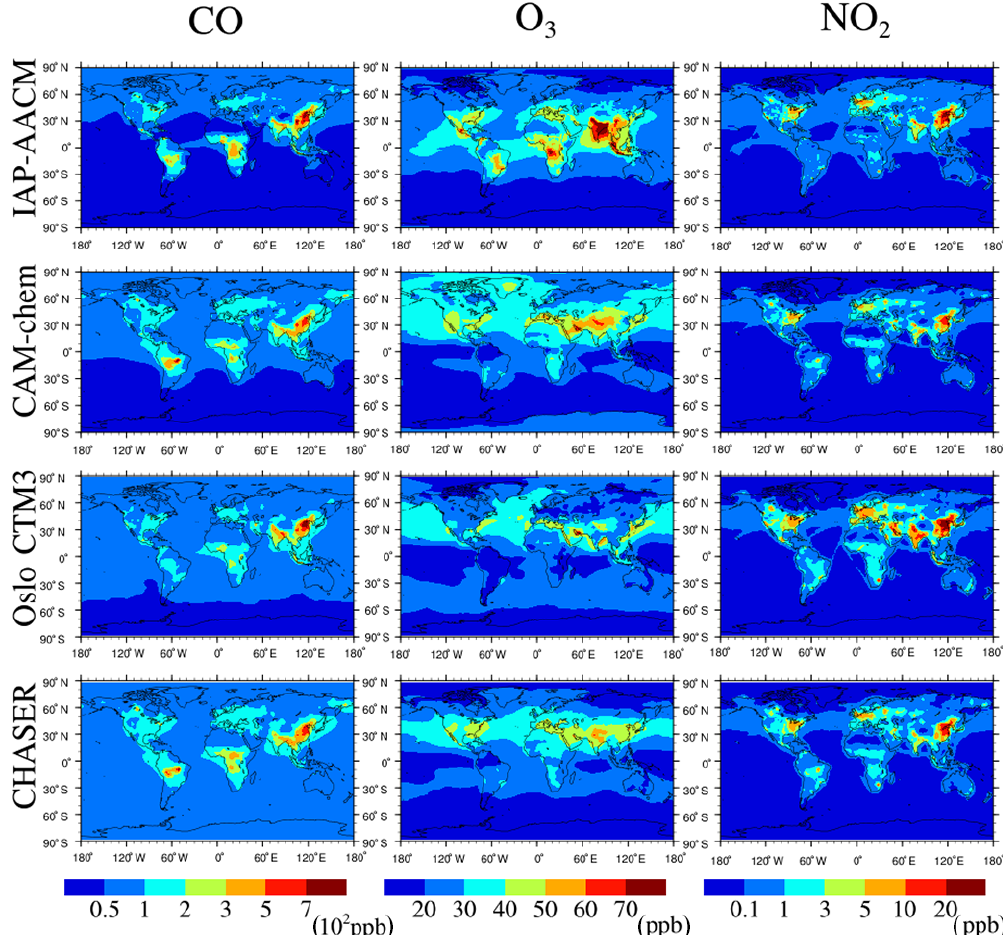
Figure 5. Annual mean surface distributions (ppb) from IAP-AACM compared with HTAP models. Rows from top to bottom represent IAP-AACM, CAM-Chem, Oslo CTM3 and CHASER respectively. The left column displays CO, the middle column displays O 3 and the right column is NO 2